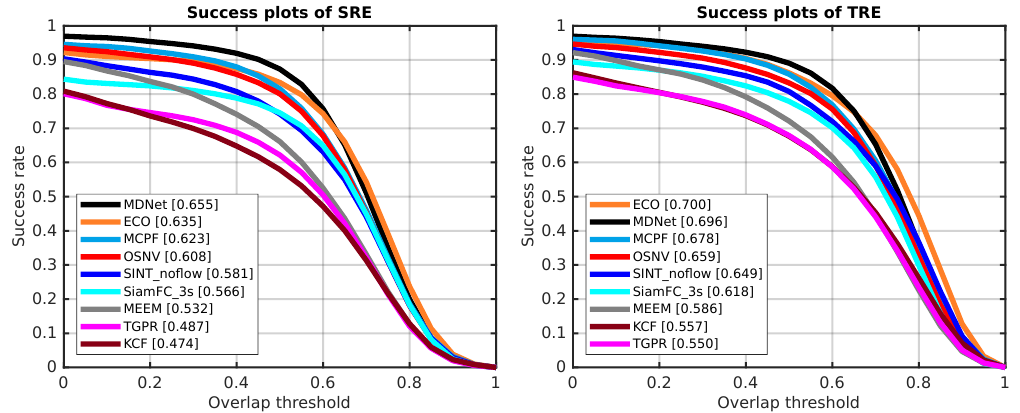
Figure 5. The robustness evaluation results of nine tracking algorithms on OTB-2013. The left side is the success plots of spatial robustness evaluation (SRE). In addition, the right side is the success plots of temporal robustness evaluation